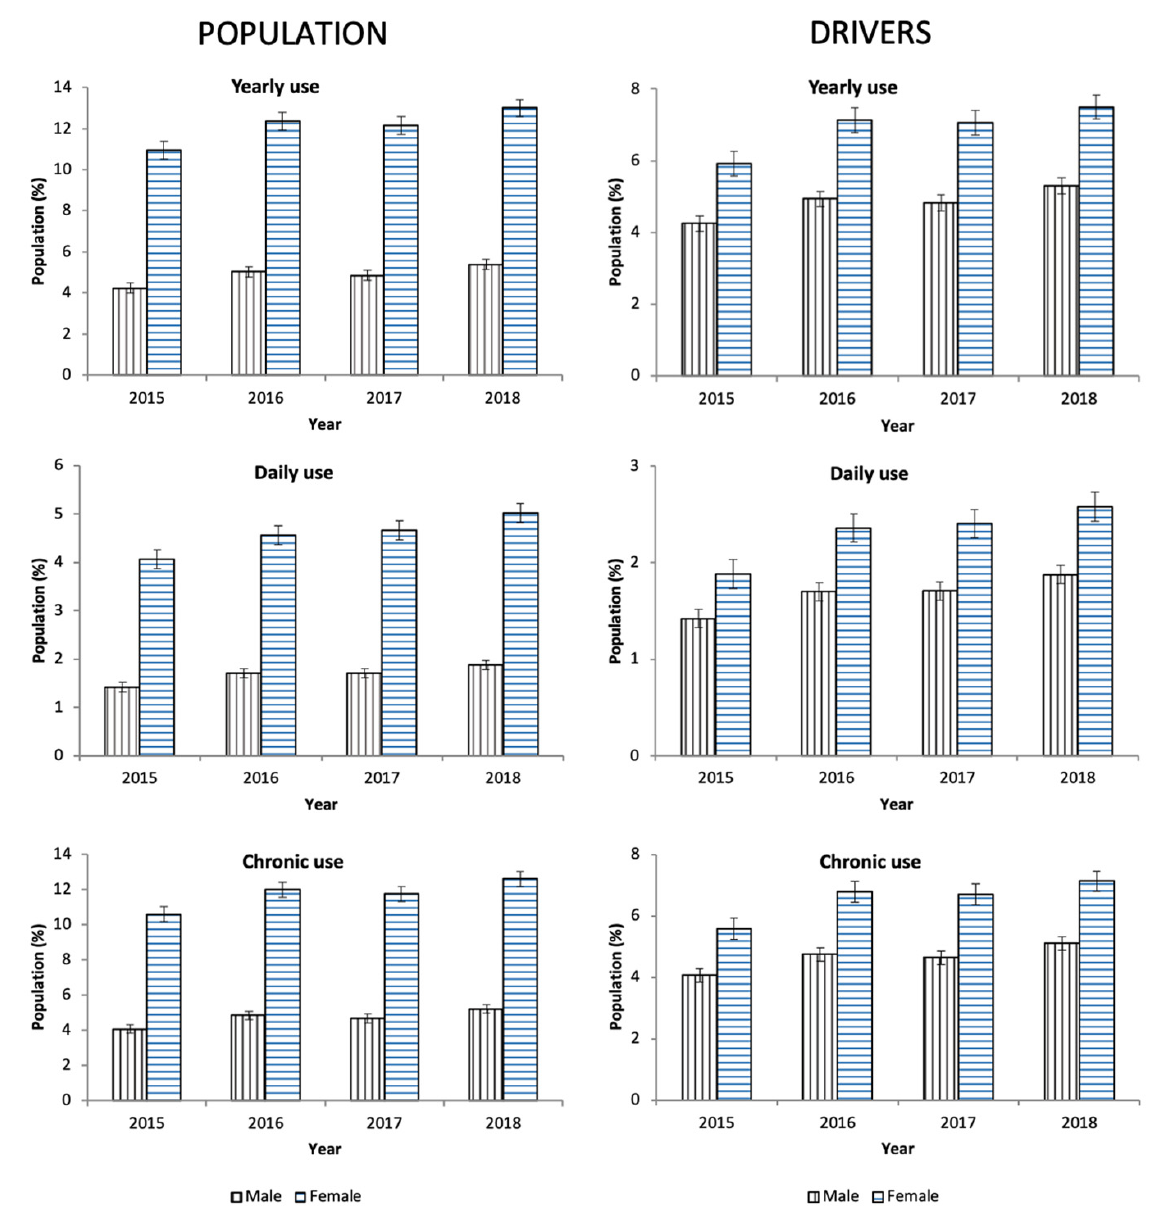
Figure 3. Evolution of antidepressants use in Castile and León (2015–2018).